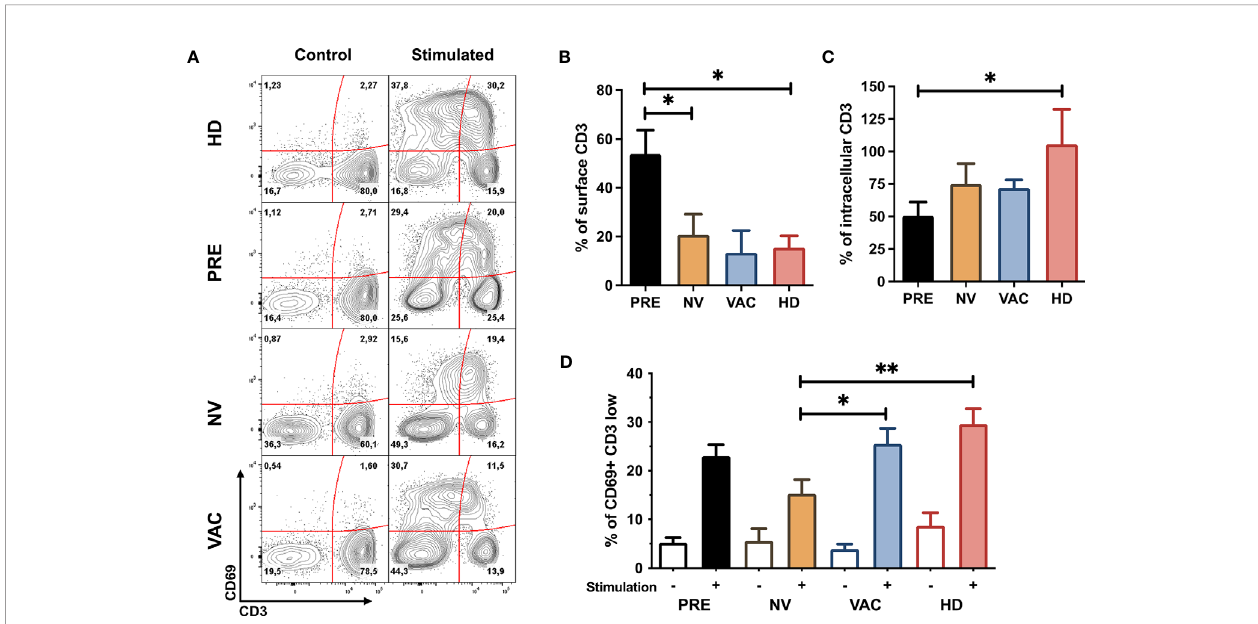
FIGURE 2 | Restoration of T-cell early activation pro fi le after neoadjuvant chemotherapy with A/C (NAC) + dendritic cell (DC) therapy. (A) Representative contour plots of CD69 vs. CD3 before and after in vitro stimulation of peripheral blood mononuclear cells (PBMCs) obtained from healthy donors (HDs) and patients before (PRE) and post-chemotherapy alone [non-vaccinated (NV)] and vaccinated patients (VAC), numbers represent percentage of cells in each quadrant. (B) Mean expression of surface CD3 (normalized compared to control samples and represented over a 100%) in HDs (red bar), before chemotherapy (PRE, black bar), non- vaccinated (NV, yellow bar), and vaccinated (VAC, blue bar) patients. (C) Quanti fi cation of intracellular CD3 (normalized to control samples and represented over a 100%) in the four groups described in panel (B) . (D) percentage of CD69+CD3low cells in the four groups of samples before stimulation (empty bars) and after in vitro stimulation (tinted bars). Non-parametric Mann – Whitney test between populations or groups. *p < 0.05, **p <